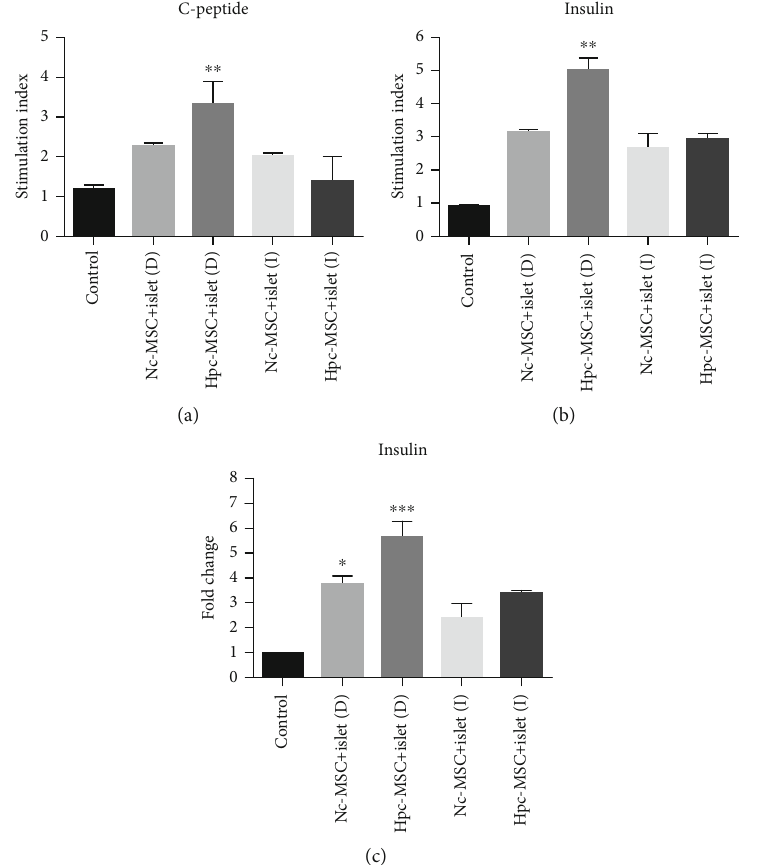
Figure 6: Glucose stimulation of (a) C-peptide and (b) insulin secretions and (c) insulin mRNA expression in human islets cocultured with Hpc-MSCs and Nc-MSCs. A comparison was done between the control and each cocultured islets. ∗ P < 0 : 05 , ∗∗ P < 0 : 01 , and ∗∗∗ P < 0 : 001 . Nc-MSCs: normoxia condition mesenchymal stem cells; Hpc-MSCs: hypoxia preconditioning MSCs; D: direct coculture; I: indirect